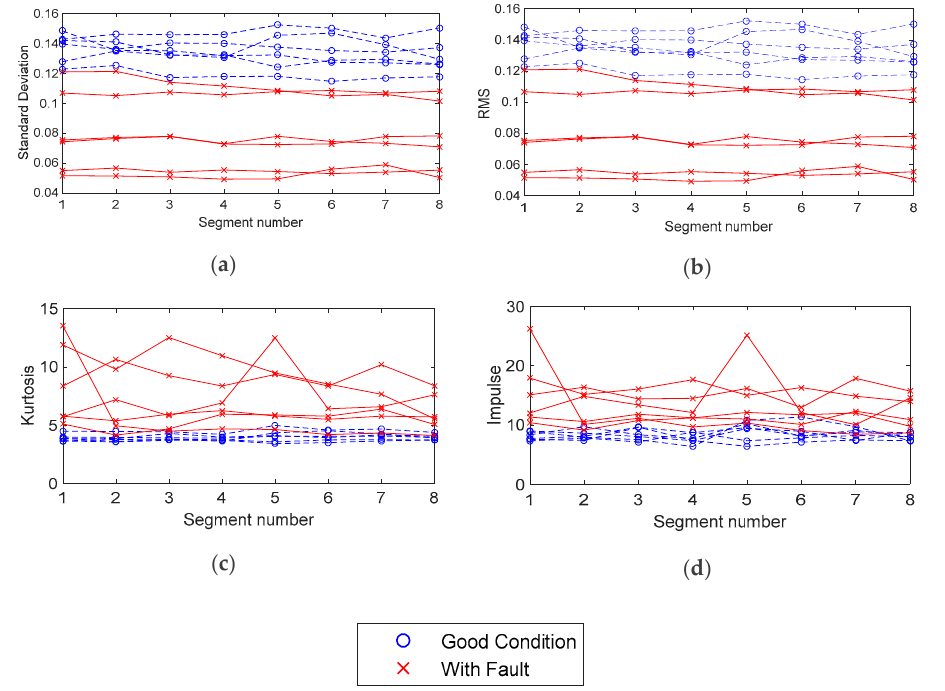
Figure 9. Statistics in the time domain, ( a ) standard deviation, ( b ) RMS value, ( c ) kurtosis and ( d ) impulse factor for gear sets in good condition and with fault.